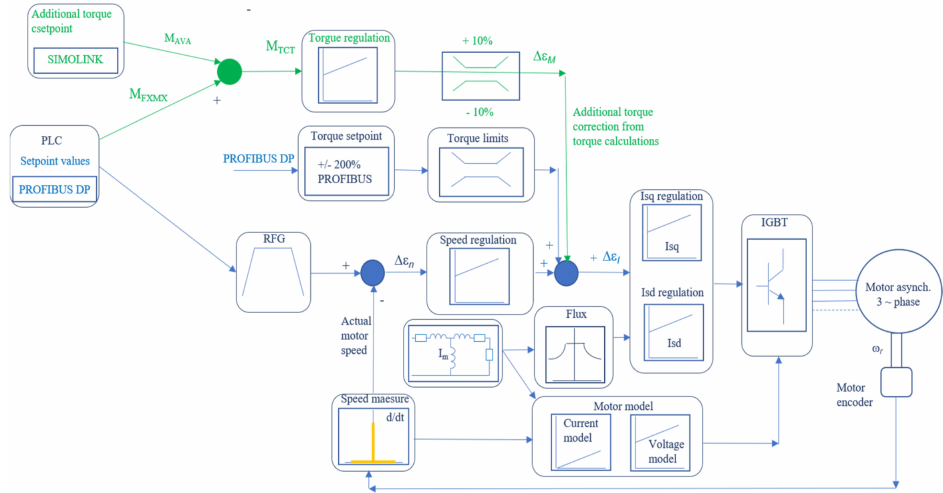
Figure 13. Block diagram of the FOC control algorithm with torque correction for the induction motor in the torque